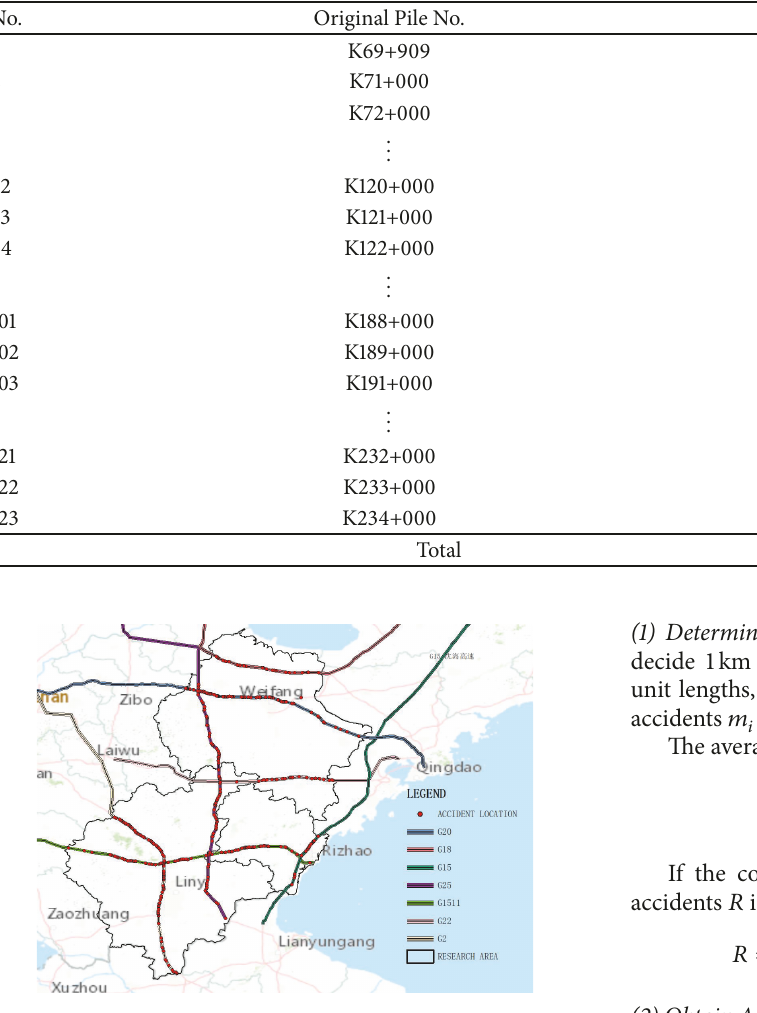
Table 1: The number of accidents on the unit road section.